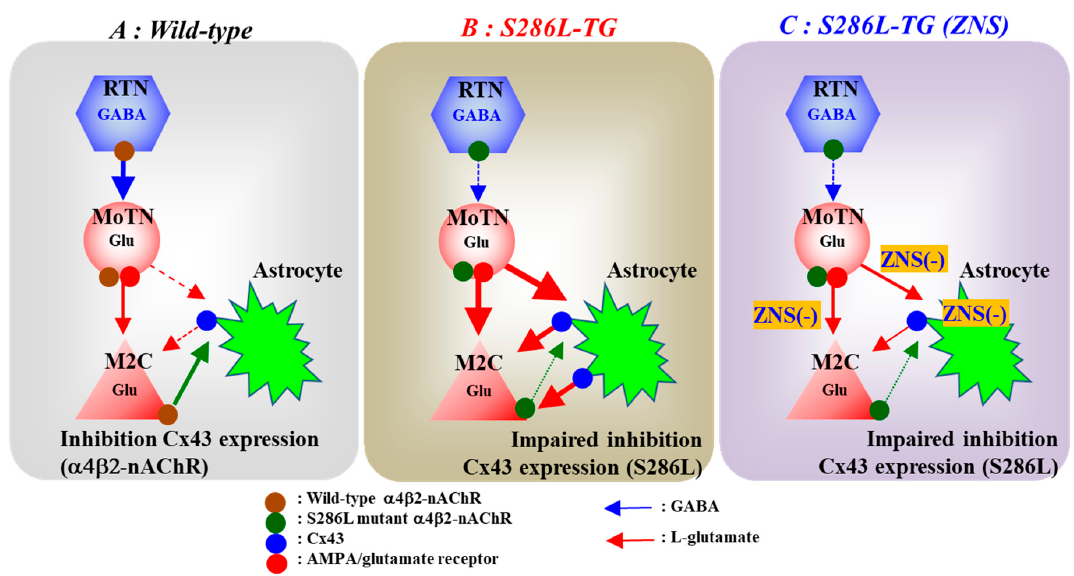
Figure 9. Proposed hypothesis of pathomechanisms and pathophysiology of S286L-TG. Proposed hypothesis for functional abnormalities of glutamatergic transmission in the thalamocortical pathways in wild-type (panel A ), S286L-TG (panel B ) and pathophysiology of ZNS-sensitive ADSHE seizure (panel C ). RTN mainly projects GABAergic terminals to MoTN. Activation of α 4 β 2-nAChR in the RTN enhances GABAergic inhibition in the RTN-MoTN pathways of wild-type (panel A). MoTN project glutamatergic terminals to the M2C. In the MoTN, both α 4 β 2-nAChR and AMPA/glutamate receptor activate glutamatergic transmission to the M2C (panel A ). Wild-type α 4 β 2-nAChR suppresses the Cx43 expression in plasma membrane (panel A). Contrary to wild-type, loss-of-function S286L-mutant α 4 β 2-nAChR attenuates the inhibition of Cx43 expression in the plasma membrane (panel B). Additionally, loss-of-function of S286L-mutant α 4 β 2-nAChRs in RTN generates GABAergic disinhibition in the MoTN, leading to enhancement of glutamatergic transmission in M2C (panel B ). Enhanced glutamatergic transmission in the M2C stimulates both glutamatergic pyramidal neurons and astrocytes resulting in activation of Cx43 (panel B ). A combination of enhanced glutamatergic transmission and Cx43 expression in the M2C are candidate mechanisms of focus generation in the M2C (panel B ). ZNS reduced Cx43 expression in the M2C (panel C ). ZNS also compensates the enhanced glutamatergic transmission in the thalamocortical glutamatergic transmission via activation of II-mGluR [22] in the MoTN and GABA release [39,62] in the M2C [21] .